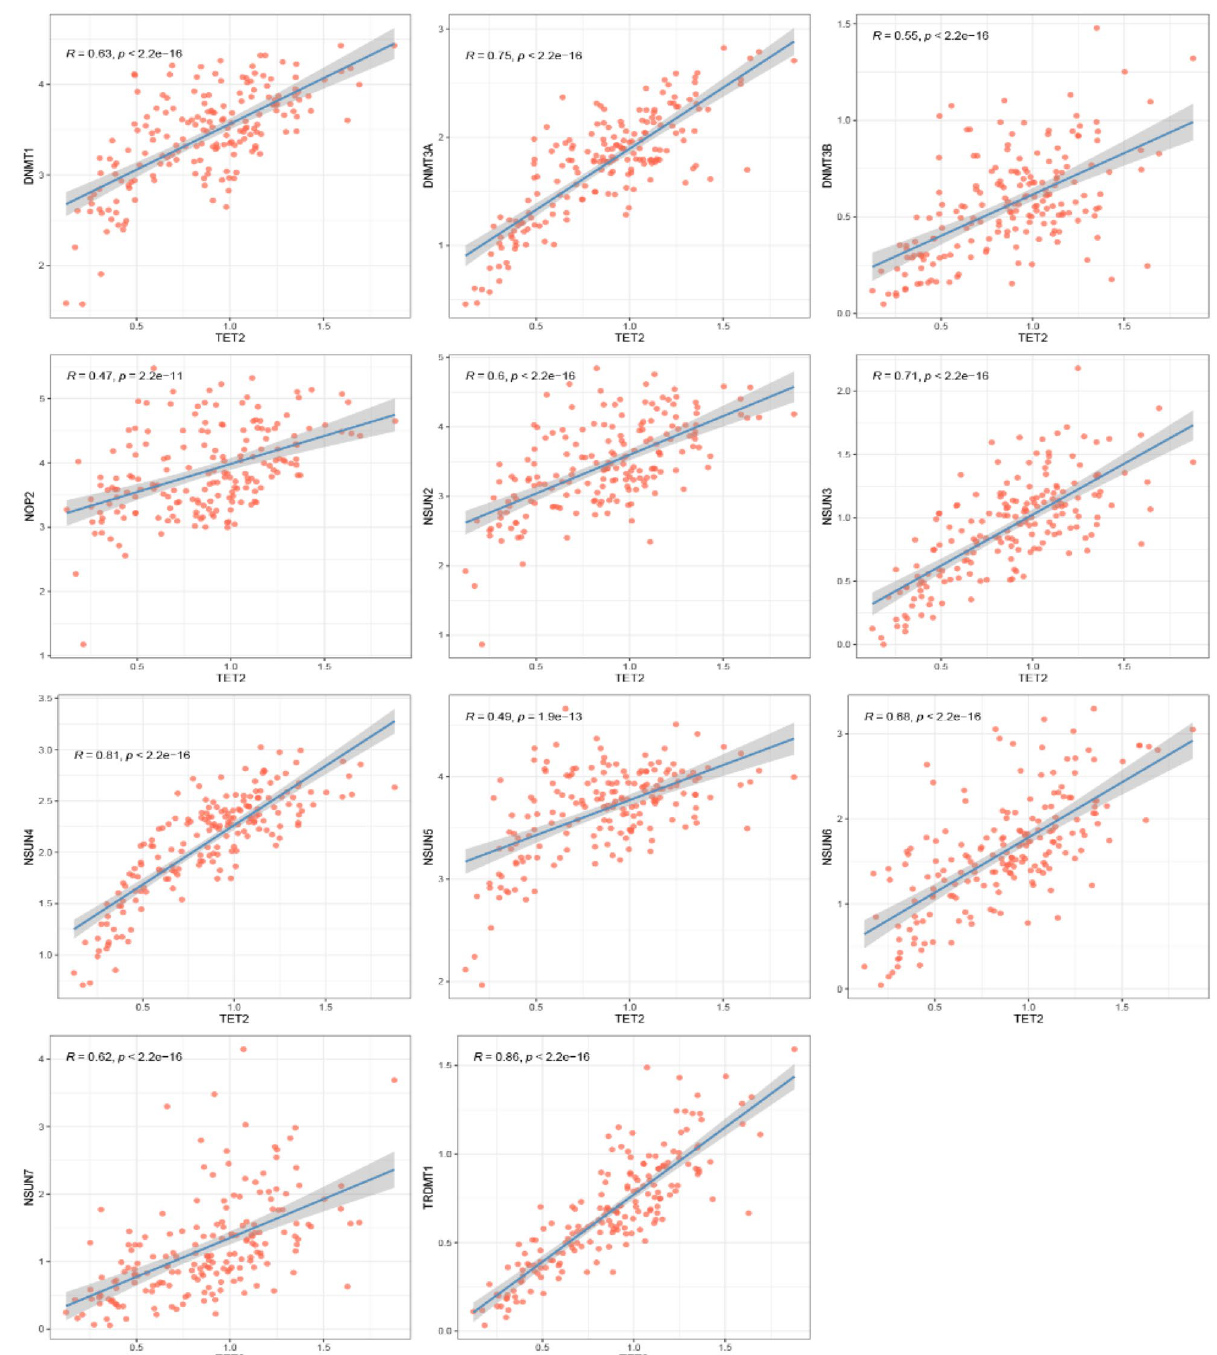
Figure 3. Correlation between m5C erasers and writers. Eraser gene: TET2. Writer genes: DNMT1, DNMT3A, DNMT3B, NOP2, NSUN2, NSUN3, NSUN4, NSUN5, NSUN6, NSUN7, TRDMT1. The threshold value: |R|> 0.4 and P < 0.001. R, correlation